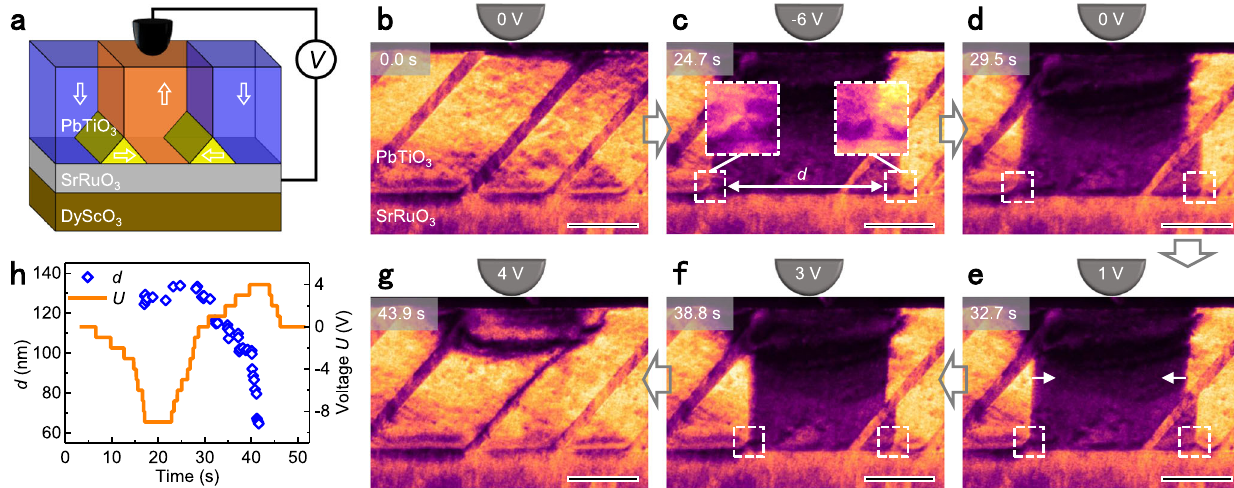
Fig.3|Electric- fi eldcontrolofisolatedthreefoldverticesatthePbTiO 3 /SrRuO 3 interface.a SchematicdiagramoftheprobebasedinsituTEMexperimentalset-up. Two isolated threefold vertices are formedatthe PbTiO 3 /SrRuO 3 interface. Arrows indicatedirectionsofpolarization. b – g AchronologicalTEMdark- fi eldimageseries illustrates the nucleation and lateral motion of two threefold vertices along the